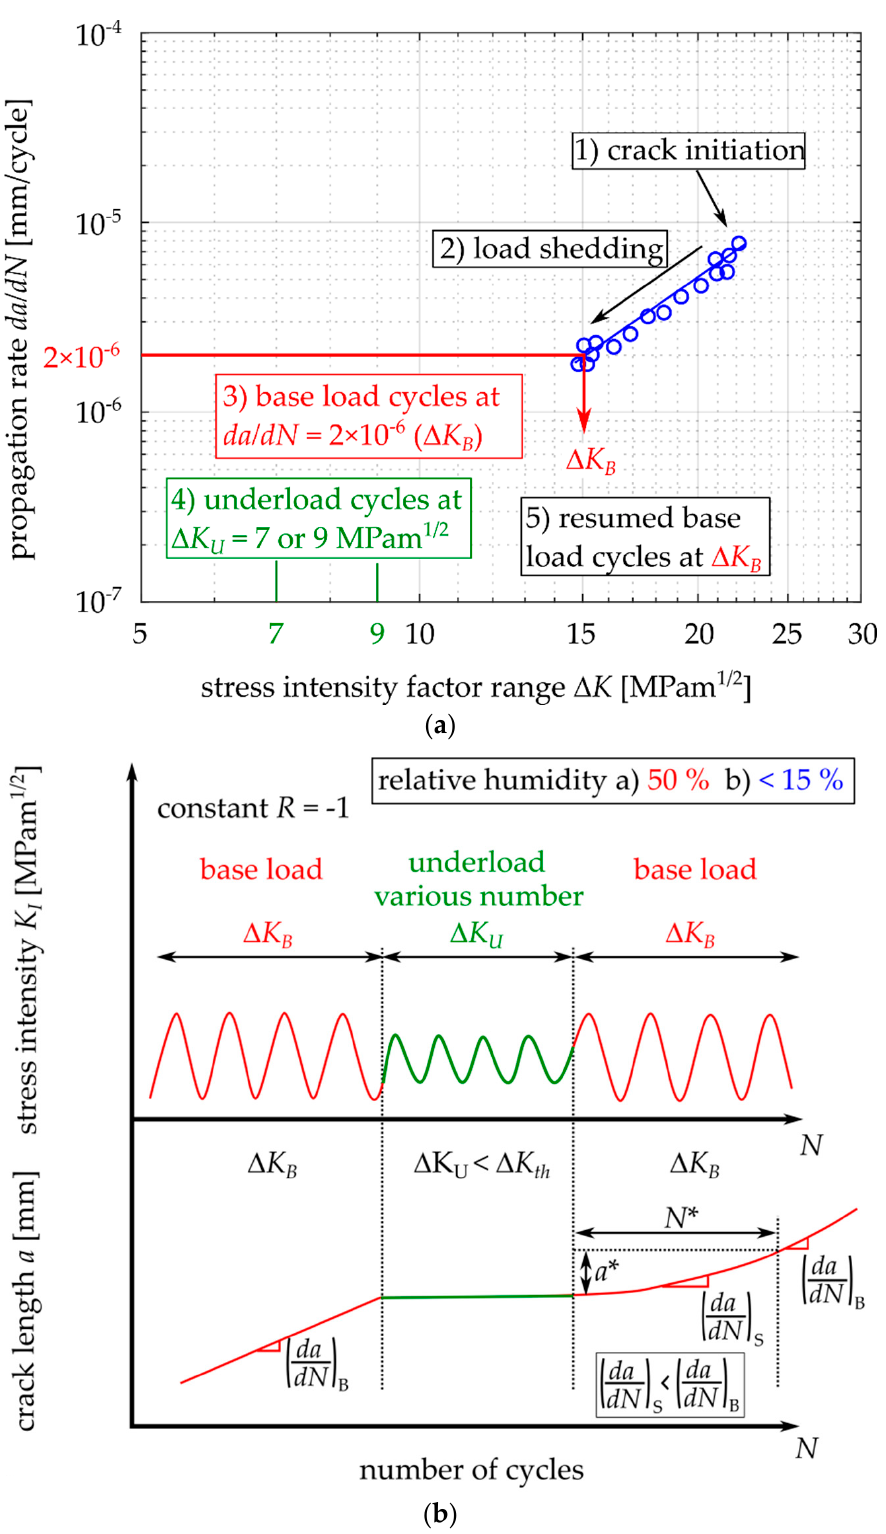
Figure 8. Scheme of the conducted experimental procedure. ( a ) Procedure steps in terms of the crack growth rate diagram; ( b ) Loading sequences. Unlike in Figure 4, various numbers of underload cycles were applied and the humidity conditions were varied.